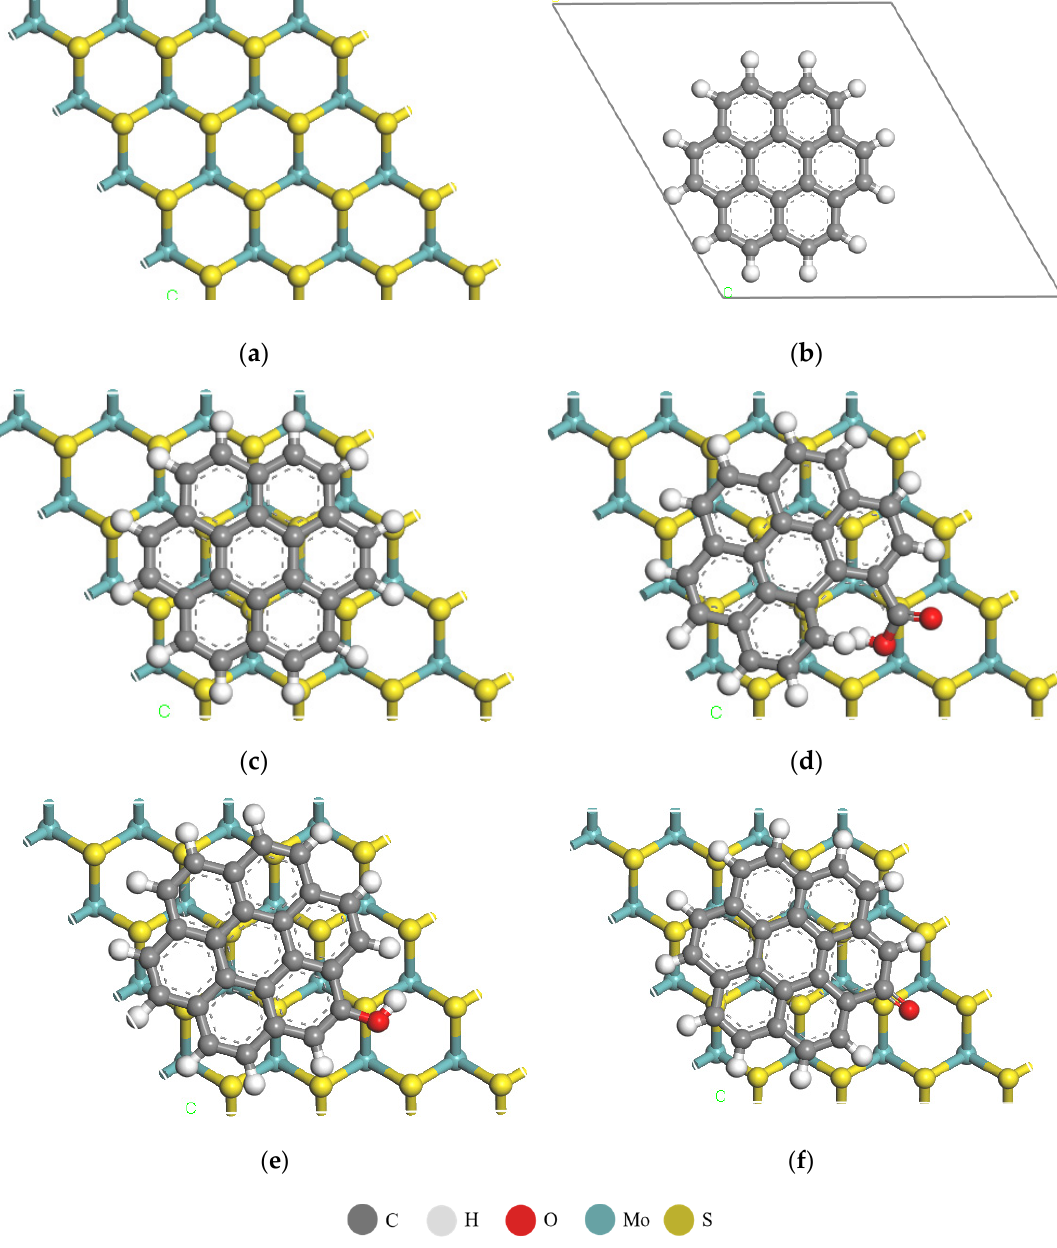
Figure 1. Geometrical structures of MoS 2 monolayer ( a ), CDs ( b ), MoS 2 /CDs heterostructures without groups ( c ), MoS 2 /CDs heterostructures with carboxyl ( d ), hydroxyl ( e ), and carbonyl ( f ).